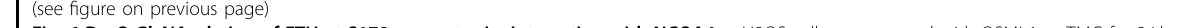
Fig. 6 De- O -GlcNAcylation of FTH at S179 promotes its interaction with NCOA4. a U2OS cells were treated with OSMI-1 or TMG for 24 h and subjected to immuno fl uorescence microscopy with antibodies against Ferritin and NCOA4. b Cell lysates from U2OS cells treated with OSMI-1 or TMG for 24 h were immunoprecipitated with antibodies against NCOA4 or FTH and IgG, and then immunoblotted with the indicated antibodies. c Cell lysates from 293T cells stably expressing the indicated proteins were immunoprecipitated with anti-GFP magnetic beads and immunoblotted with the indicated antibodies. d Cell lysates from U2OS cells treated with OSMI-1 or TMG for 24 h were immunoprecipitated with antibodies against FTH and immunoblotted with the indicated antibodies. e Cell lysates from U2OS cells treated with OSMI-1 or TMG for 24 h were pulled down with sWGA and immunoblotted with the indicated antibodies. f , g Cell lysates from U2OS cells were immunoprecipitated with antibodies against FTH or OGT and IgG and immunoblotted with the indicated antibodies. h , i Cell lysates from U2OS cells treated with RSL3 for the indicated time were immunoprecipitated with antibodies against FTH and immunoblotted with the indicated antibodies. The relative optical intensity was quanti fi ed. j Cell lysates from 293T cells stably expressing the indicated proteins were immunoprecipitated with anti-GFP magnetic beads and immunoblotted with the indicated antibodies. k U2OS cells were transfected with indicated plasmids for 24 h. Cells were stained with LysoTracker and immunostained with anti-NCOA4 antibody, and then subjected to confocal microscopy. l U2OS cells were transfected with indicated plasmids for 24 h, and incubated with RSL3 for 8 h. Cells were stained with PI and assessed by fl ow cytometry, and the percentage of GFP/PI double-positive cells was quanti fi ed. m Model for the regulation of O -GlcNAcylation in ferroptosis via ferritinophagy and mitophagy. Inhibition of O -GlcNAcylation promoted ferritinophagy by increasing the interaction between FTH and NCOA4, resulting in the accumulation of labile iron which may fl ux toward mitochondria. Decreased O -GlcNAcylation also resulted in mitochondria fragmentation and enhanced mitophagy, providing additional source for labile iron and rendering the cell to be more sensitive to ferroptosis. Scale bars, 10 μ m. * P < 0.05, *** P < 0.001, **** P < 0.0001; ns, not signi fi cant. Error bars indicate